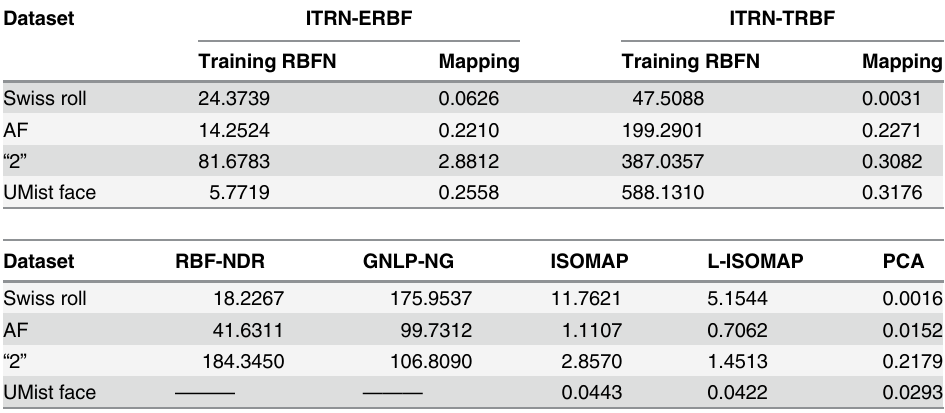
Table 3. Running times (specified in seconds) for different